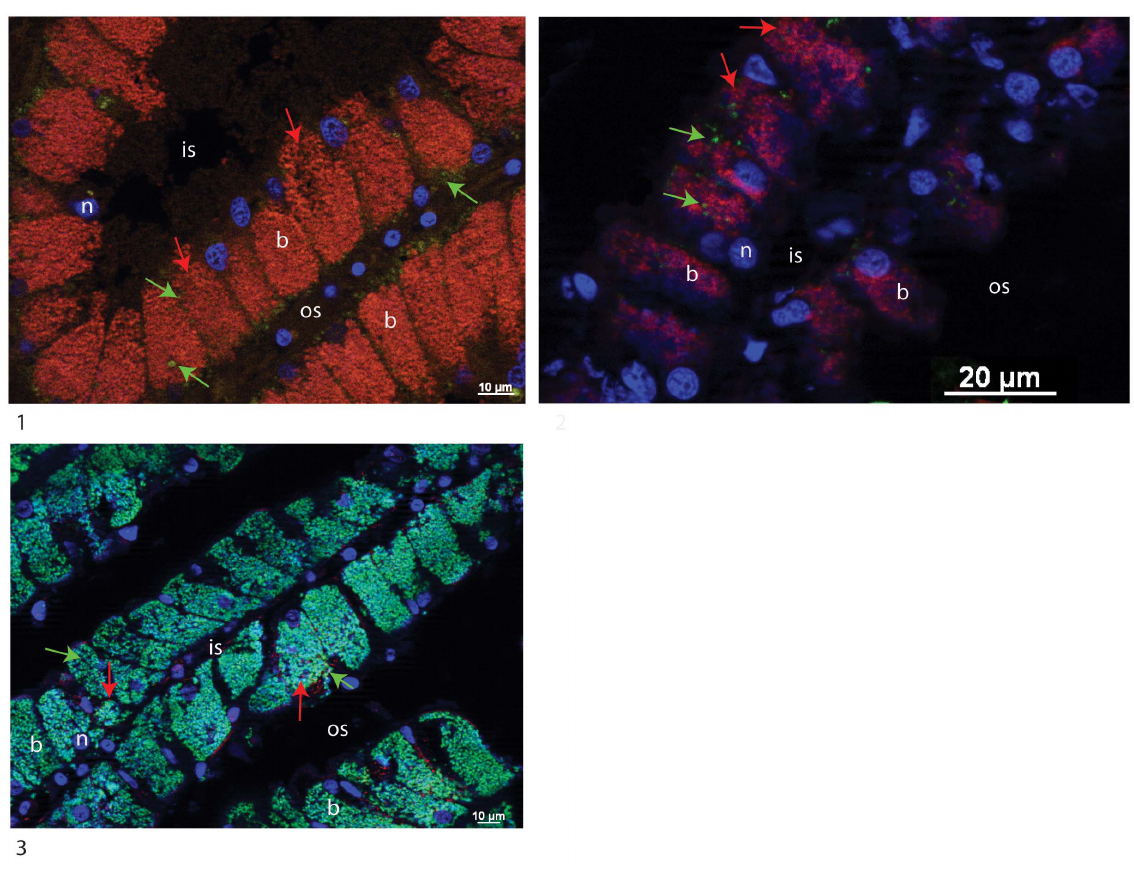
Figure 6. Cross-sections of gills dissected from C.regab (1 and 2) and L.chuni (3) (1:217-V2 and 2:225- V3 and 3:225-V1) and hybridized with Creg821 (Cy5, stained in red) and Lchun821 (Cy3, stained in green) FISH probes, and counterstained with DAPI (in blue). In addition to the expected symbiont 16S rRNA phylotype, the unexpected phylotype is visible. Arrows indicate bacteria hybridized with both Creg821 (red) and Lchu821 (green). For individuals shown, a single (1 and 2) or two symbionts (3) were detected with 16S rRNA PCR probes. Images from specific probes and DAPI staining(3) do not overlap perfectly, possibly due to low activity in some bacteria. b: bacteriocyte, n: nucleus, os: outer lamellar space, is: intralamellar space.